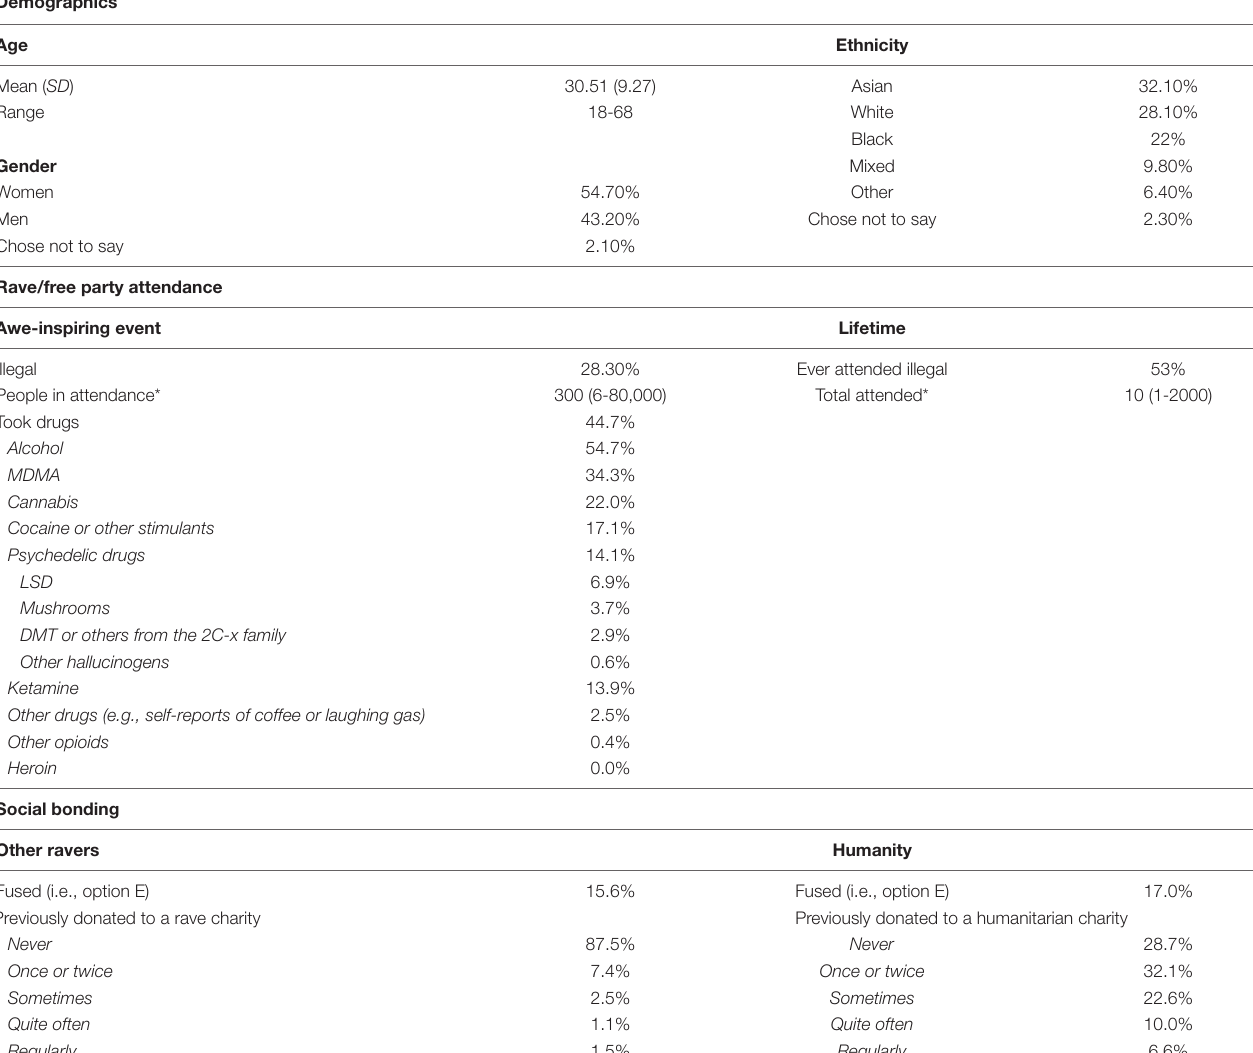
TABLE 2 | Descriptive statistics for key